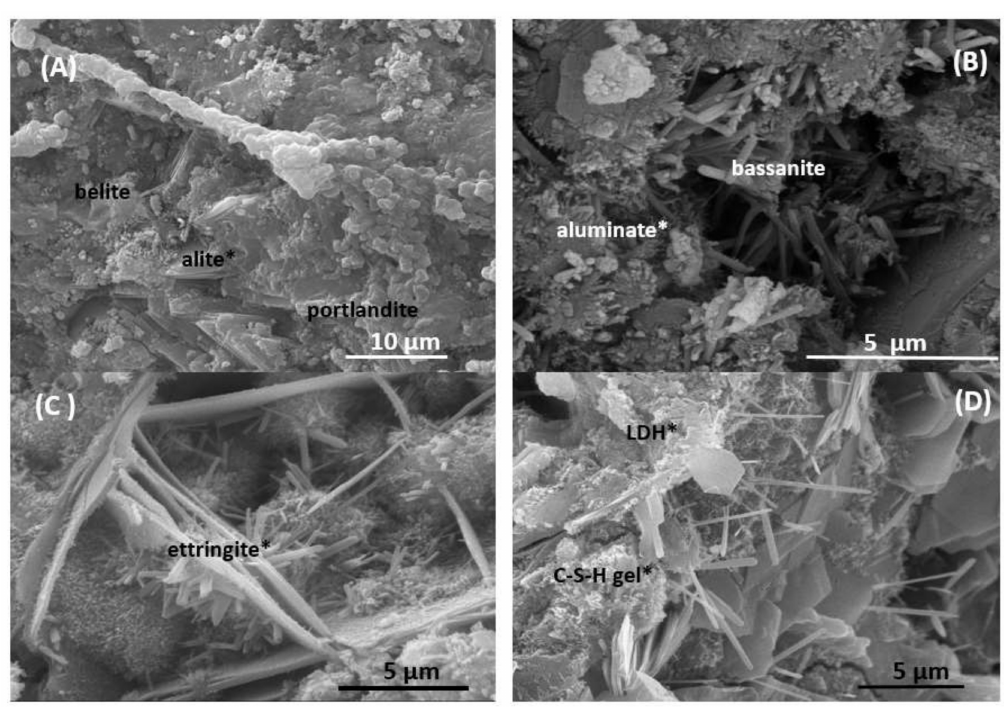
Figure 8. Reaction phases from CPO. ( A , B ) CPO at 0 days. ( C ) Ettringite at 7 days. ( D ) C-S-H gel and LDH at 360 days (* indicates the analysis point listed in Table